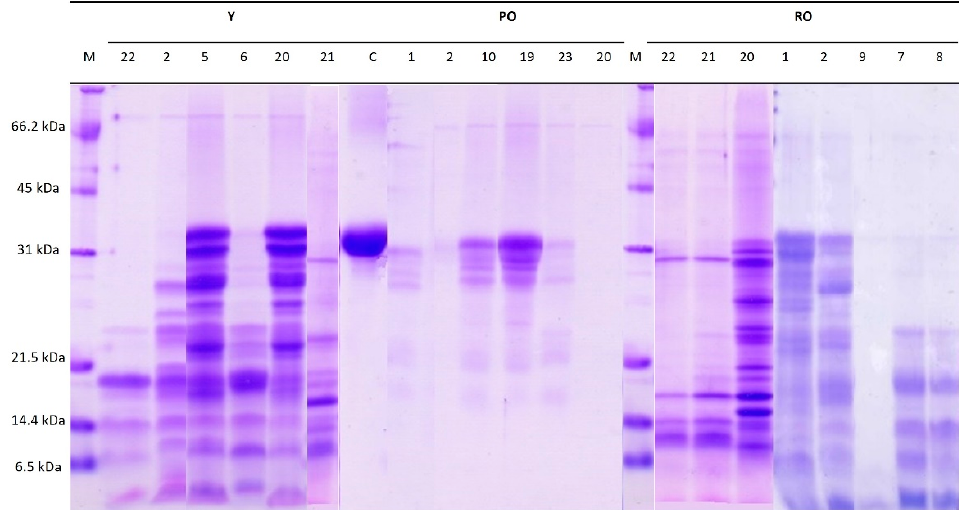
Figure 1. SDS–PAGE electrophoresis of α -casein hydrolyzed with different strains of Y. lipolytica after 72 h of incubation. C: α -casein alone (~34 kDa), M: Protein marker.